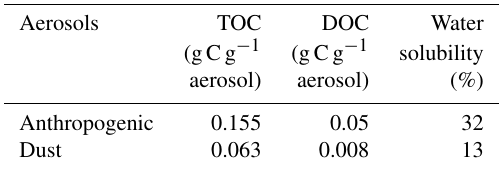
Table 1. Total organic carbon (TOC) and dissolved organic carbon (DOC) content in anthropogenic and Saharan dust aerosols used for bacterial